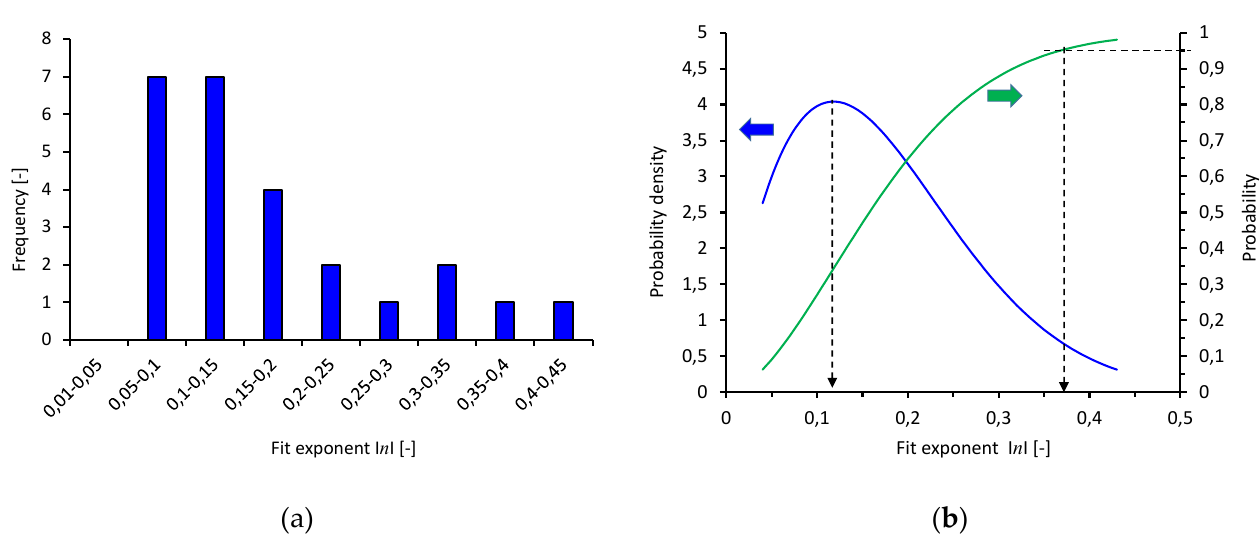
Figure 6. ( a ) Histogram of the fit exponents ( | n | ) from Table 1, ( b ) corresponding Weibull curves, scale parameter 1.727, shape parameter 0.195, coefficient of determination R 2 = 0.895.